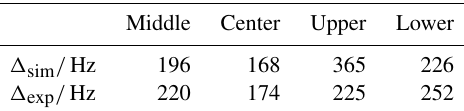
Table 1. Tabulated values of the line widths at half maximum of the simulated and experimental spectra of natural abundance glycine. The values are extracted from the spectra shown in Fig. 8 and are without chemical-shift correction. In order to obtain the real value, they have to be divided by a factor of